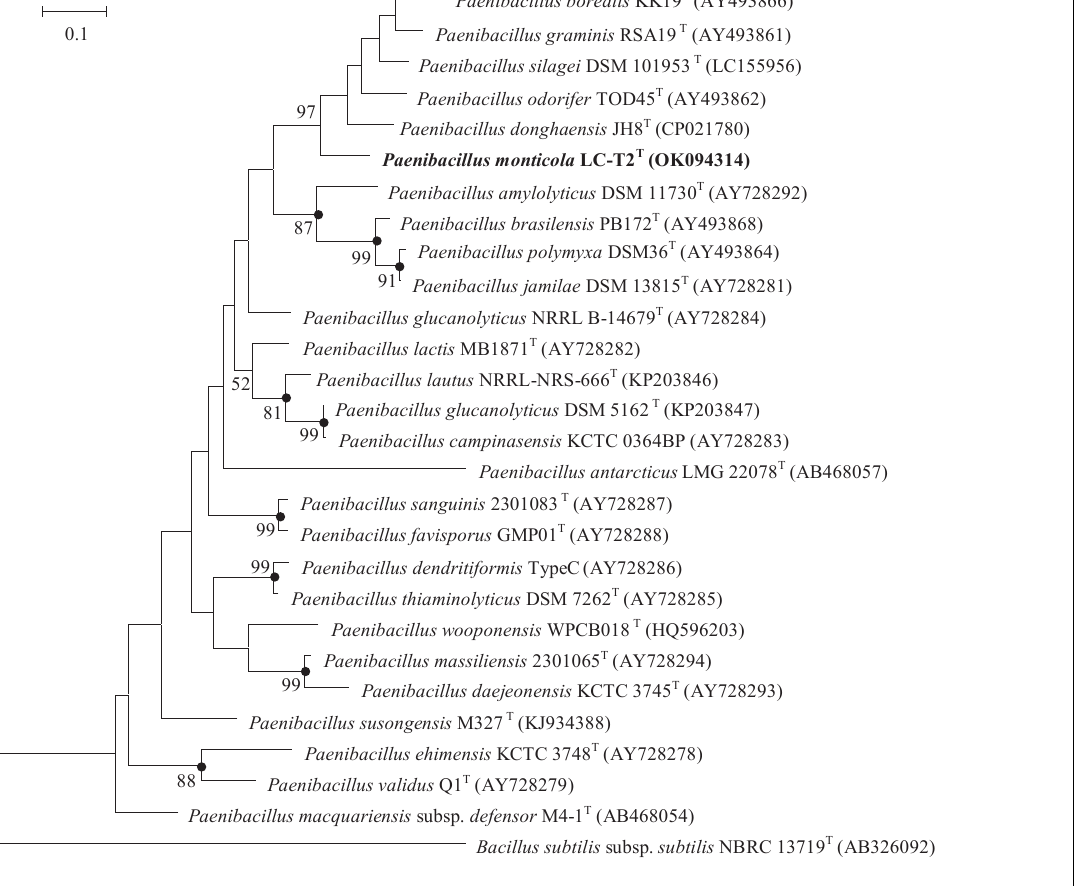
phylogenetically divergent from the cluster of any recognized species of the genus Paenibacillus ( Supplementary Figure 2 ).